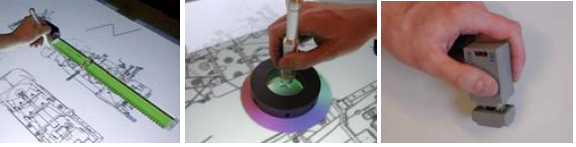
allows detecting the orientation